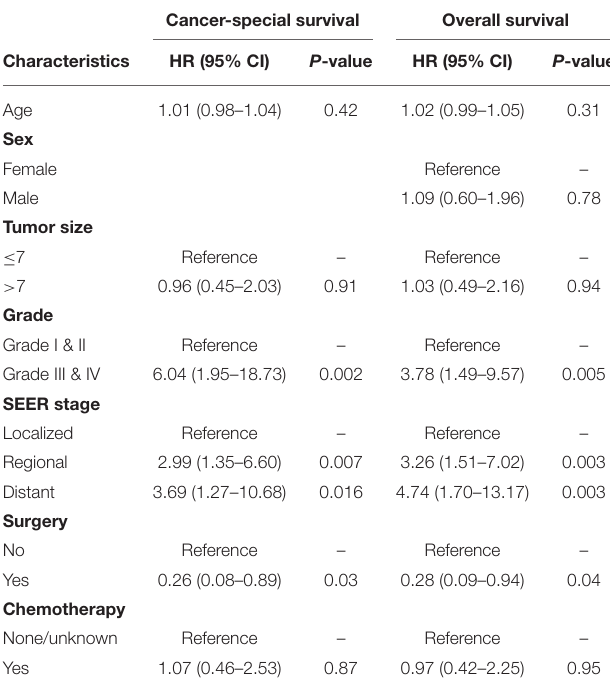
TABLE 2 | The univariable Cox proportional hazard regression model of cancer-specific and overall survival for primary renal leiomyosarcoma. Cancer-special survival Overall survival